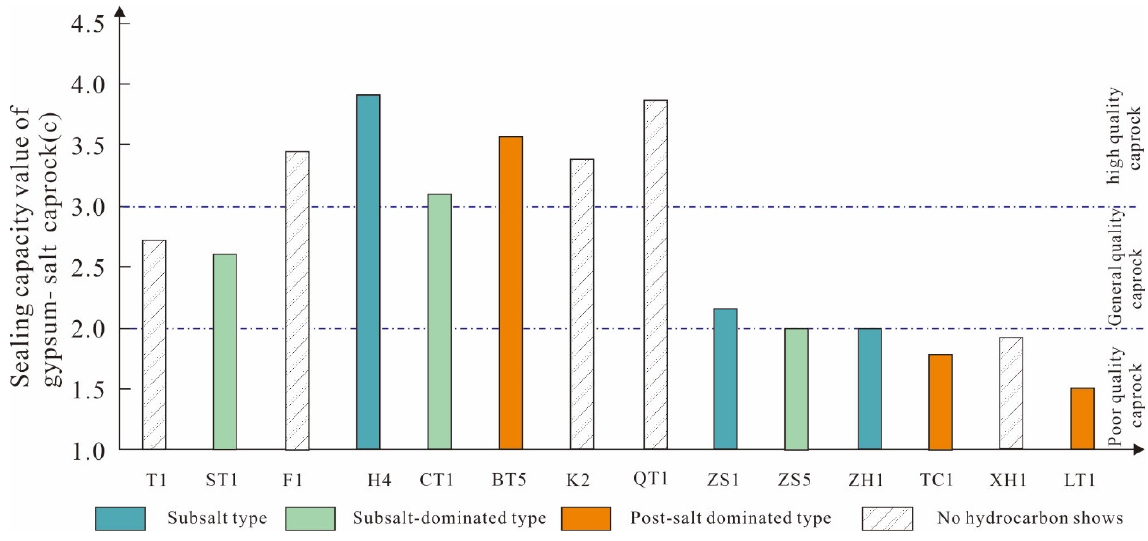
Figure 9. Evaluation results of sealing ability of Cambrian gypsum-salt rock and hydrocarbon display analysis diagram in the Tarim Basin. The dotted line is the dividing line of caprock quality. The caprock sealing capacity value (C) in the range of 1–2 is the caprock with poor quality, in the range